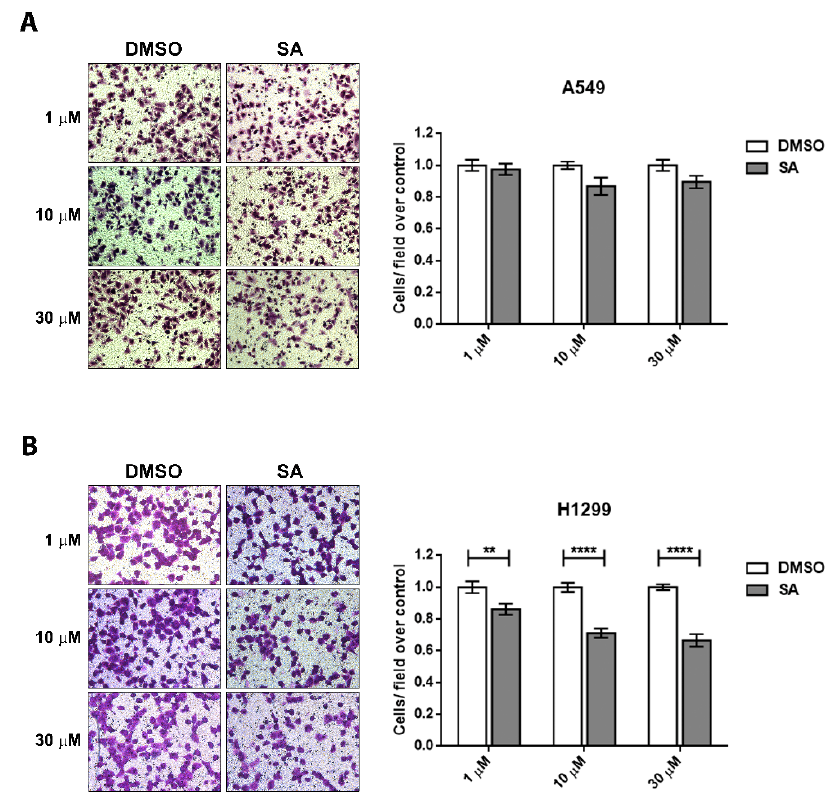
Figure 5. Sterculic acid reduces cell migration capacity in lung cancer cell lines. SA-treated A549 ( A ) and H1299 ( B ) cells were allowed to migrate across collagen-coated transwell chambers for 24 h. Representative fields of cell migration are included in figure. Data represents mean ± SEM of migrating cells with respect to its DMSO control from at least four independent biological replicates. White bars correspond to cells treated with vehicle (DMSO) while grey bars correspond to cells treated with SA (1–30 µM). ** p < 0.01, **** p < 0.0001.